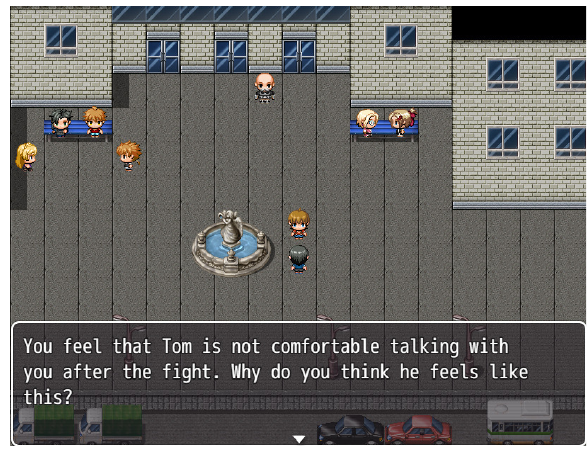
Fig. 2. Screenshot of the video game (I). In this part of the game, the character managed by the youngster is asked about the feelings of other character of the